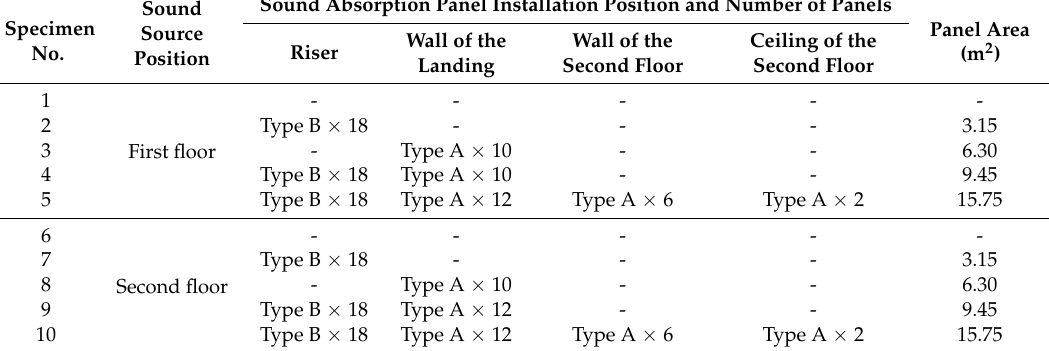
Table 2. Sound source position, sound absorption panel type, installation position, number of panels and panel area.